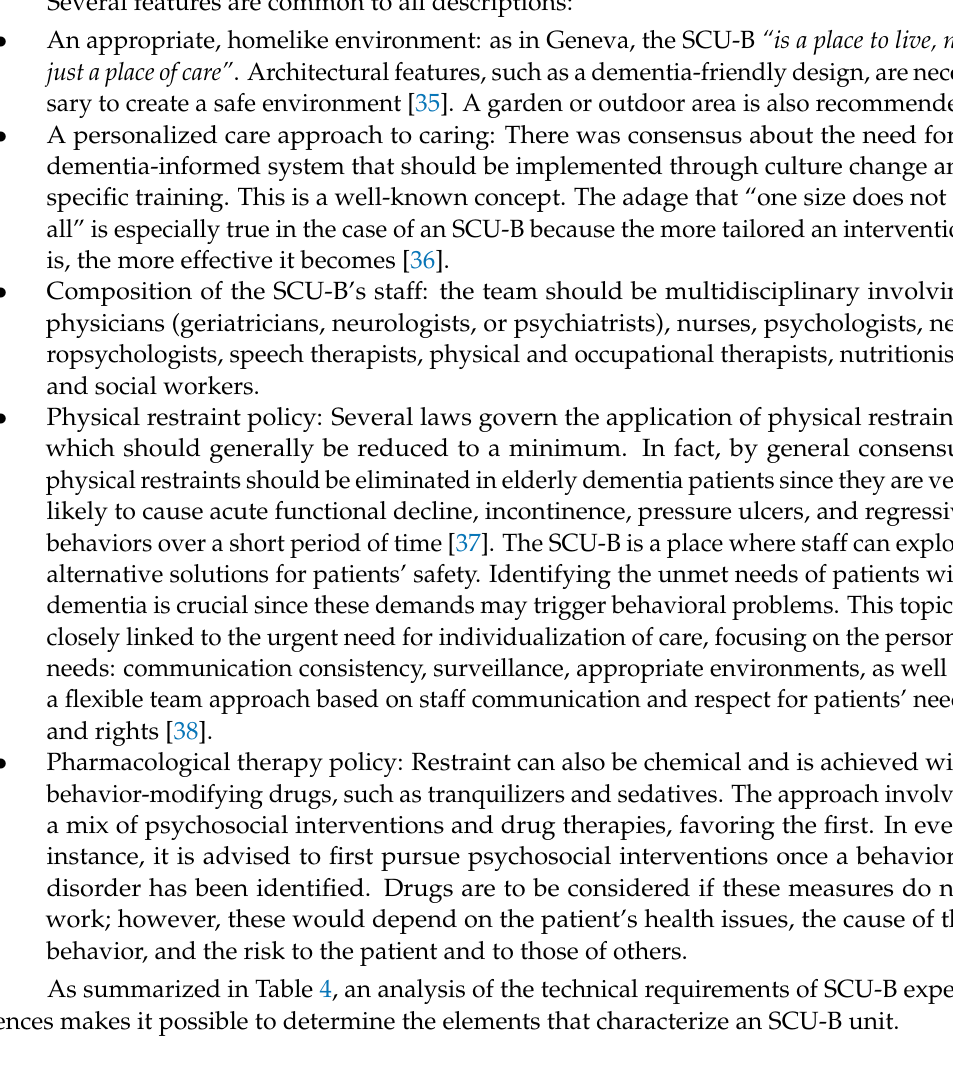
Table 4. Elements characterizing the